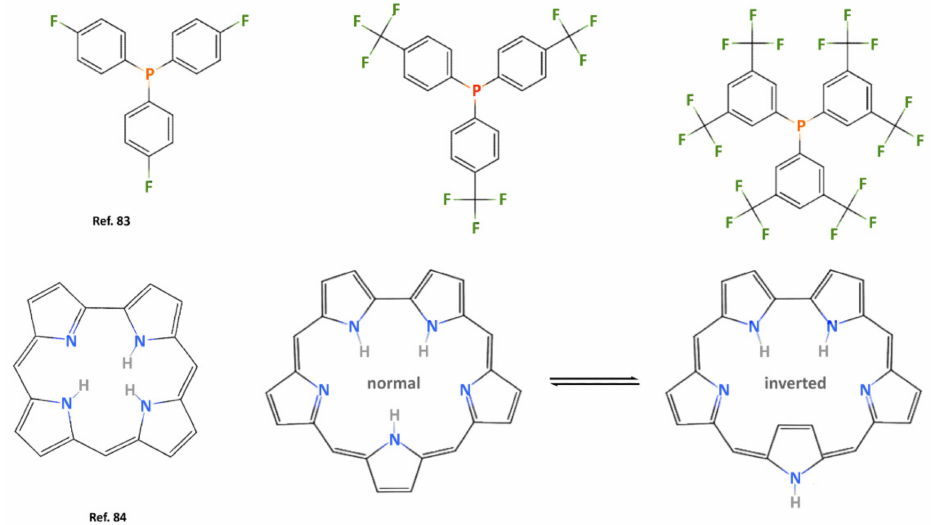
Figure 6. Molecular structures of some miscellaneous